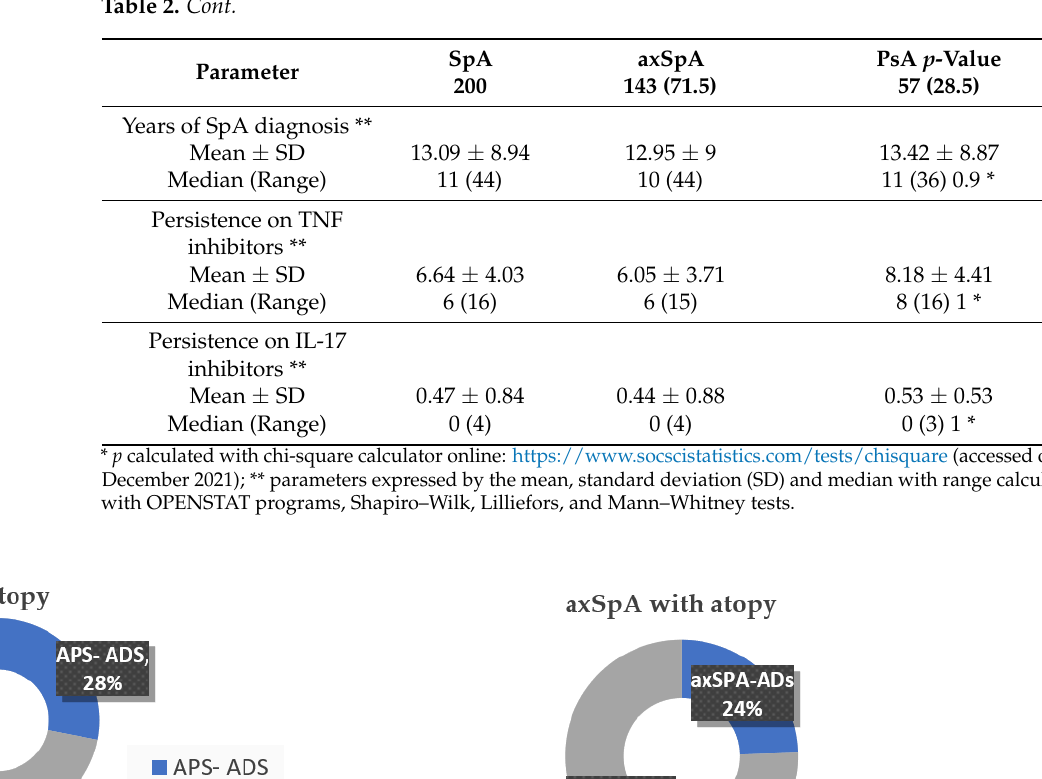
into account all 51 patients with SpA and atopic symptoms sometimes during their